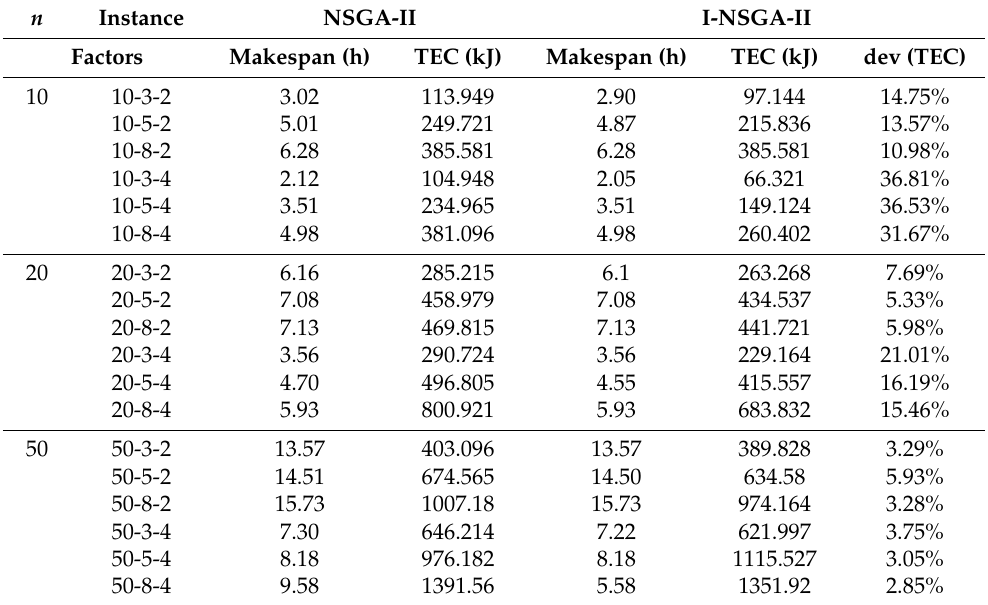
Table 6. Comparisons of algorithmic BEST performance.